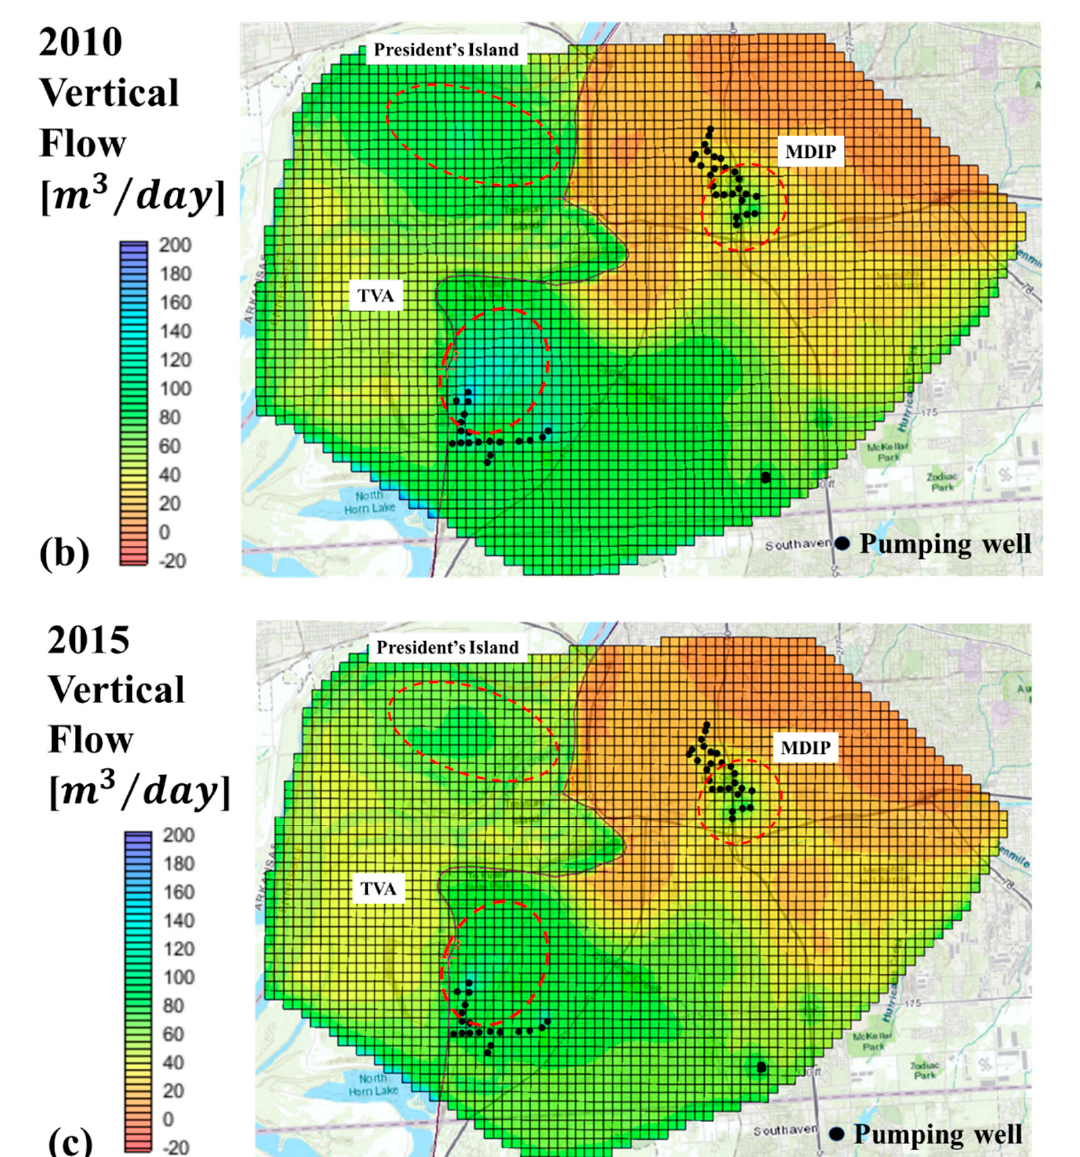
Figure 11. ( a – c ) maps show vertical flow budgets at the bottom of the Shallow aquifer in 2005, 2010, and 2015, respectively. Negative values refer to upward flow, and positive values refer to downward flows.